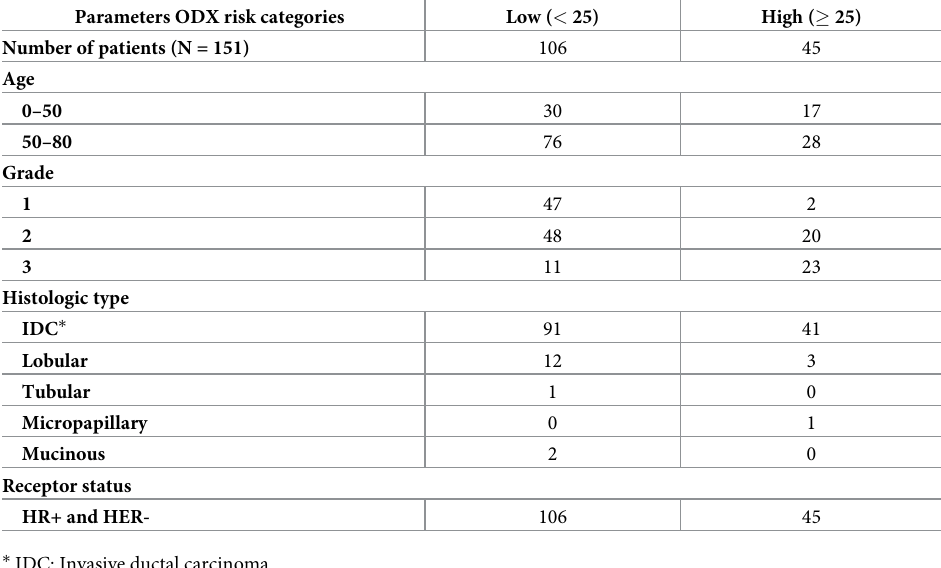
Table 1. Dataset information—Key characteristics distribution for two risk